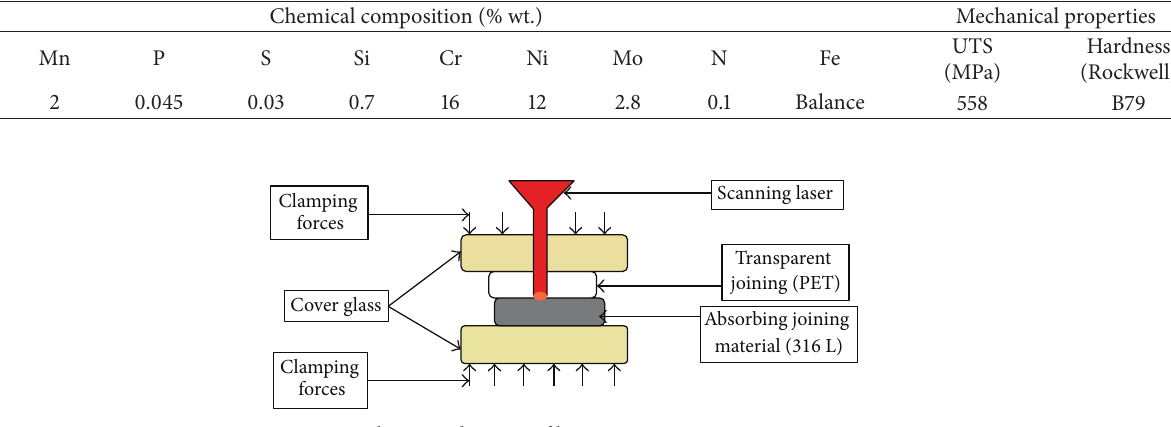
Figure 1: Schematic diagram of laser transmission joining process.